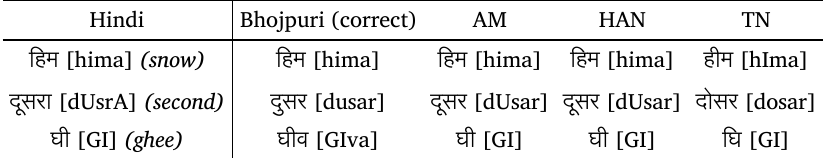
Table 11: Handling hrasva (short) and deergh (long) varna (letter)